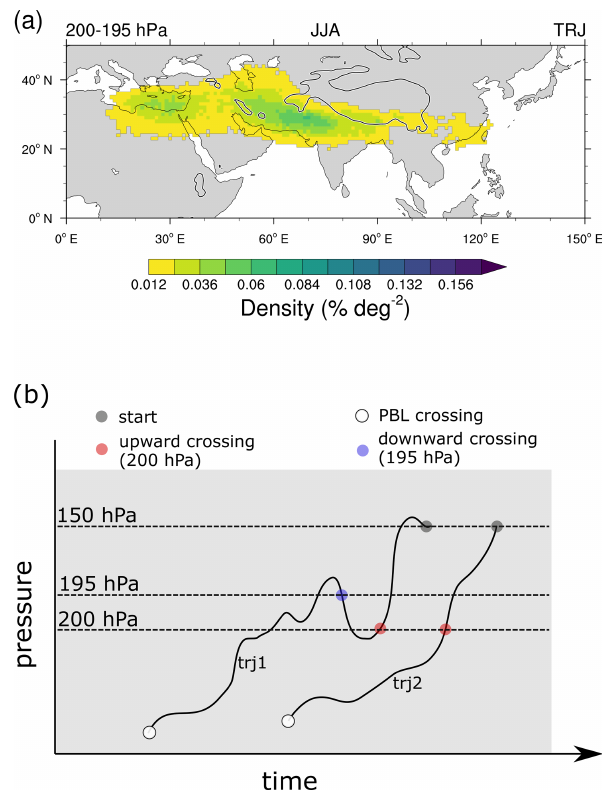
Figure 4. (a) Density of downward crossings of trajectories (%deg − 2 ) at 195hPa for trajectories that start within the AMA and cross the PBL (as defined before) and fall below 200hPa before they reach the final destination at 150hPa. Roughly 60% of the PBL crossing trajectories experience this downward crossing, and the coloured area corresponds to roughly 32% of the PBL crossing trajectories. (b) Schematic of trajectory crossings described in panel (a) and in Fig. 3. See text for